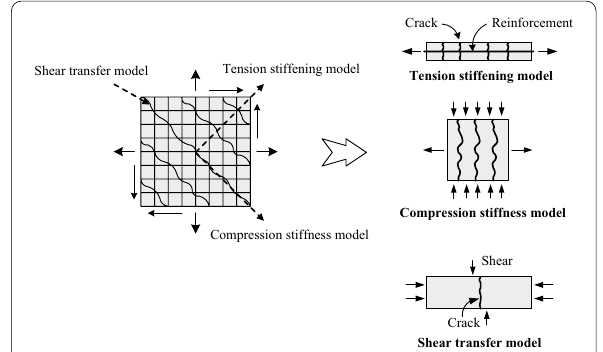
Fig. 1 Construction of cracked concrete model.